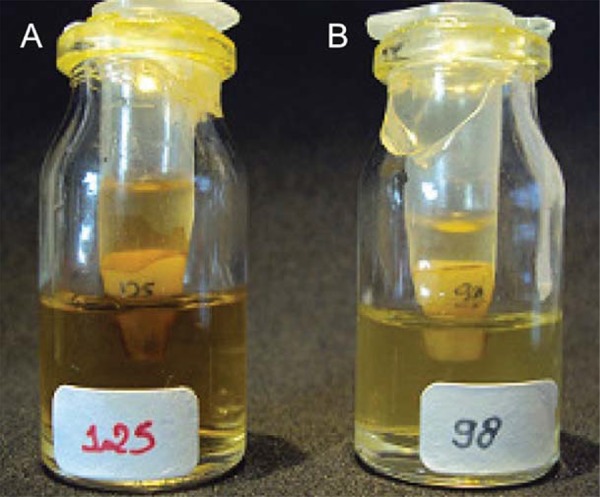
Representative leakage apparatus used for the experiment. Negative microbial growth is shown in A and positive microbial growth can be observed in B